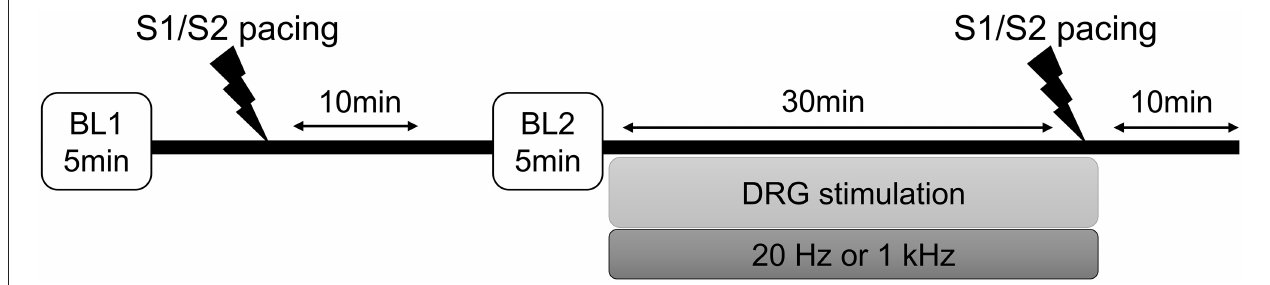
FIGURE 1 | Experimental protocol. Programmed ventricular extrastimulation (S1/S2 ventricular pacing) was performed on eight Yorkshire pigs to induce cardiac sympathoexcitation and testing for ventricular arrhythmogenicity. The efficacy of the dorsal root ganglion stimulation (DRGS) was assessed in reducing sympathoexcitation and cardiac excitability. A 10-min period was allowed after each pacing for return to baseline conditions. In two pigs, this protocol was performed for both 20 Hz and 1 kHz, where enough time was allowed to return to the baseline condition before repeating the protocol for another stimulation parameter. BL,